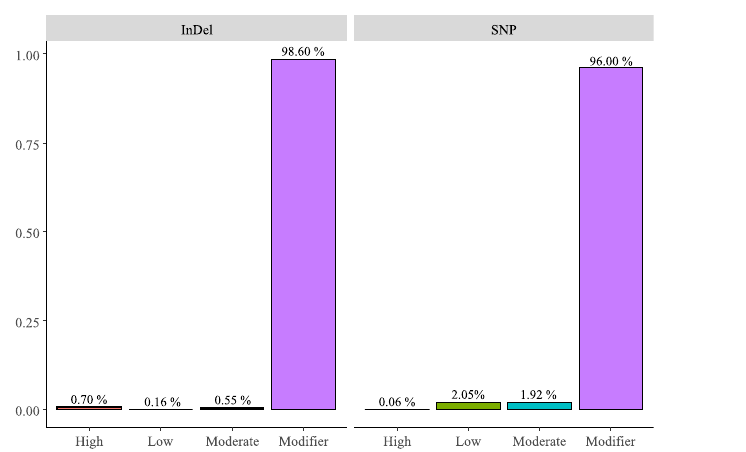
Figure 2. Number of InDel and SNP effects by